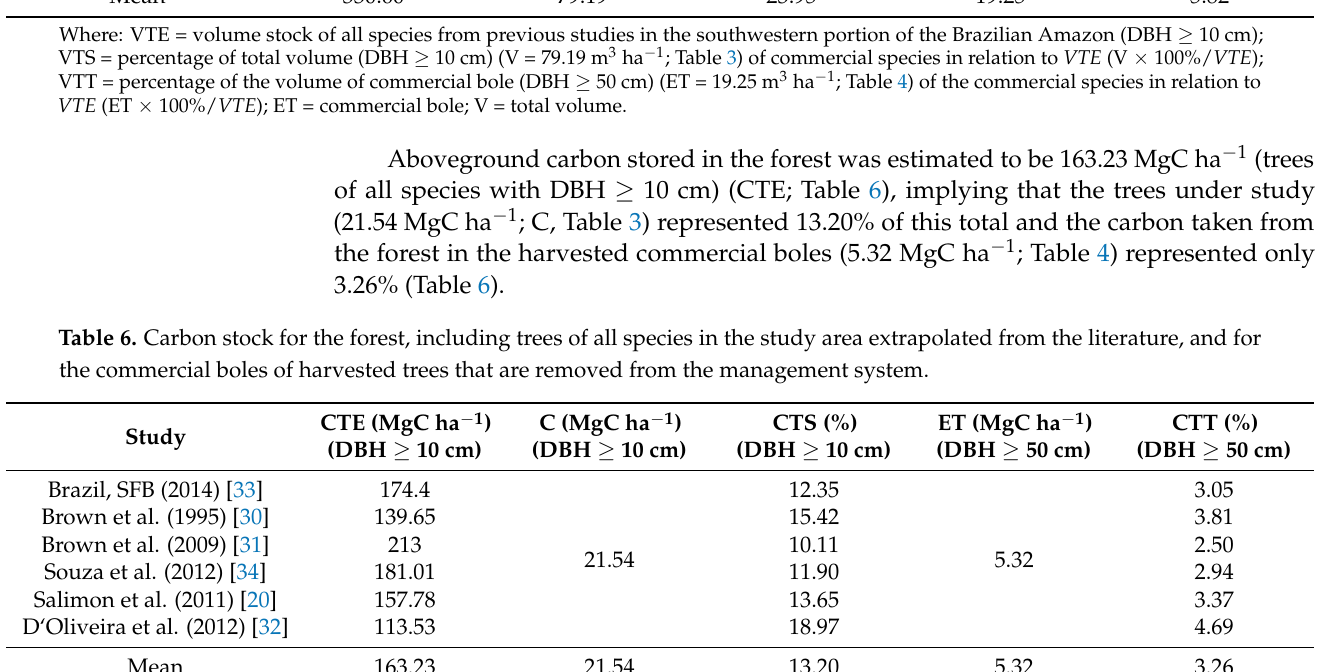
Where: VTE = volume stock of all species from previous studies in the southwestern portion of the Brazilian Amazon (DBH ≥ 10 cm); VTS = percentage of total volume (DBH ≥ 10 cm) (V = 79.19 m 3 ha − 1 ; Table 3) of commercial species in relation to VTE (V × 100%/ VTE );